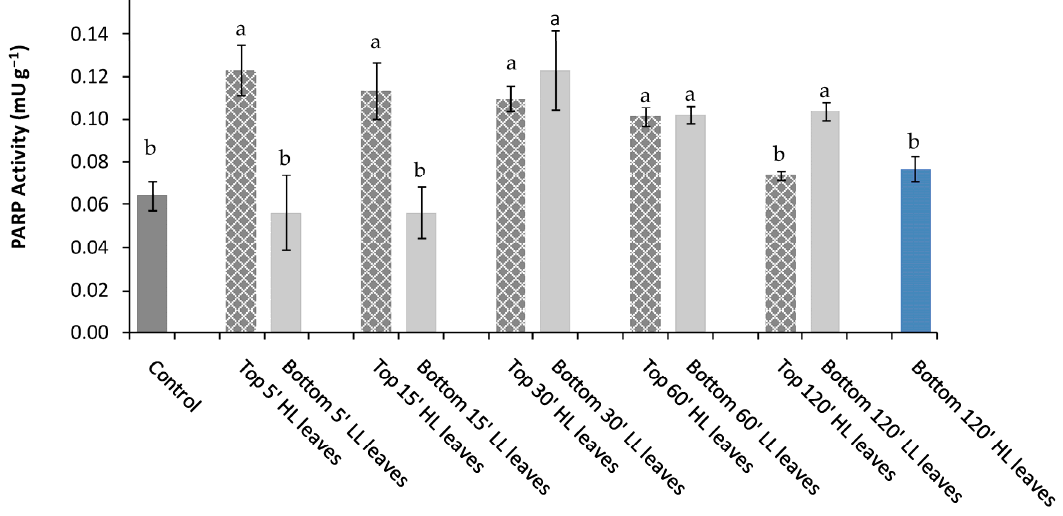
Figure 2. PARP activity in P. vulgaris L. Control, Top5’, 15’, 30’, 60’ and 120’ HL leaves (inducing stressed after 5’, 15’, 30’, 60’ and 120’ of light stress), Bottom LL leaves (receiving unstressed) and Bottom 120’ HL leaves (receiving leaves after 120’ of light stress). Different letters indicate statistically significant difference among treatments ( p ≤ 0.05) by One-Way ANOVA followed by Holm-Sidak post-hoc test.